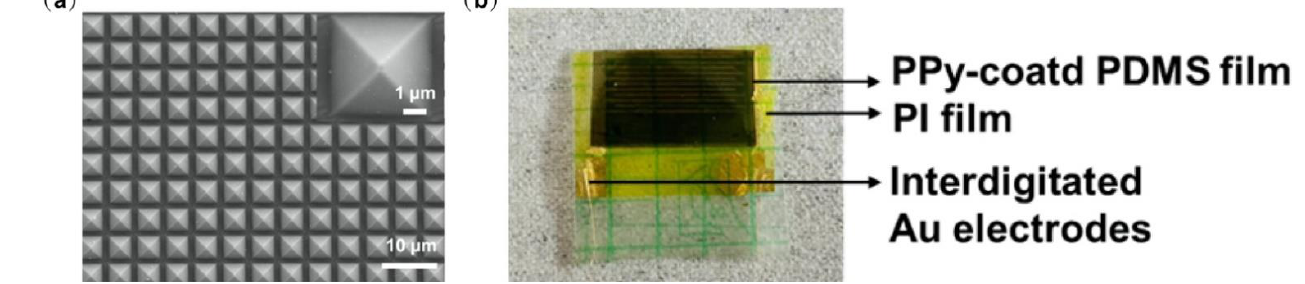
Figure 8. ( a ) SEM image of micro-pyramidal PPy-based PDMS surface. The inset illustrates a detailed SEM image of the individual structure. ( b ) Optical image of the